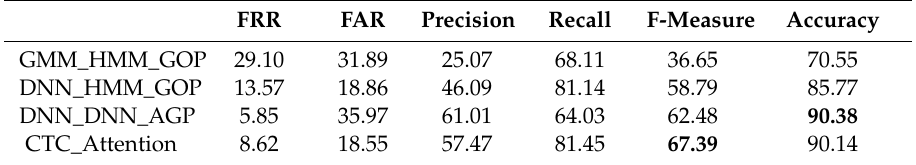
Table 9. Performance evaluation of di ff erent APED systems for all initials and finals in